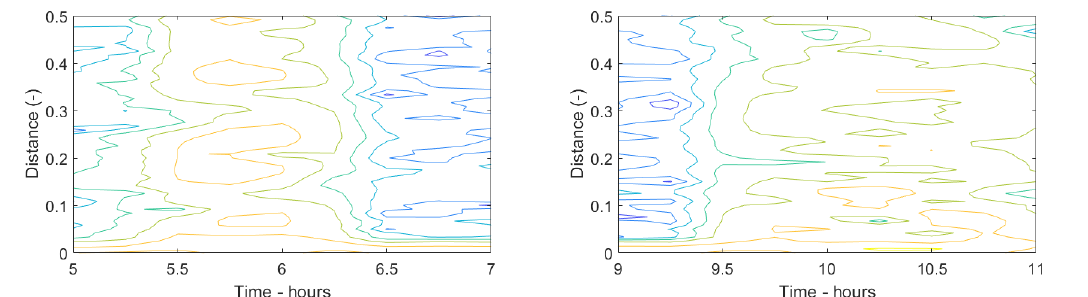
Figure 8. Contour plot of power output for variable wind speed conditions. Left : MOOP optimization. Right : global optimization. The maximum value (red) corresponds to a 90–100% power extraction, while the lowest value (blue) corresponds to 0–10% power extraction.